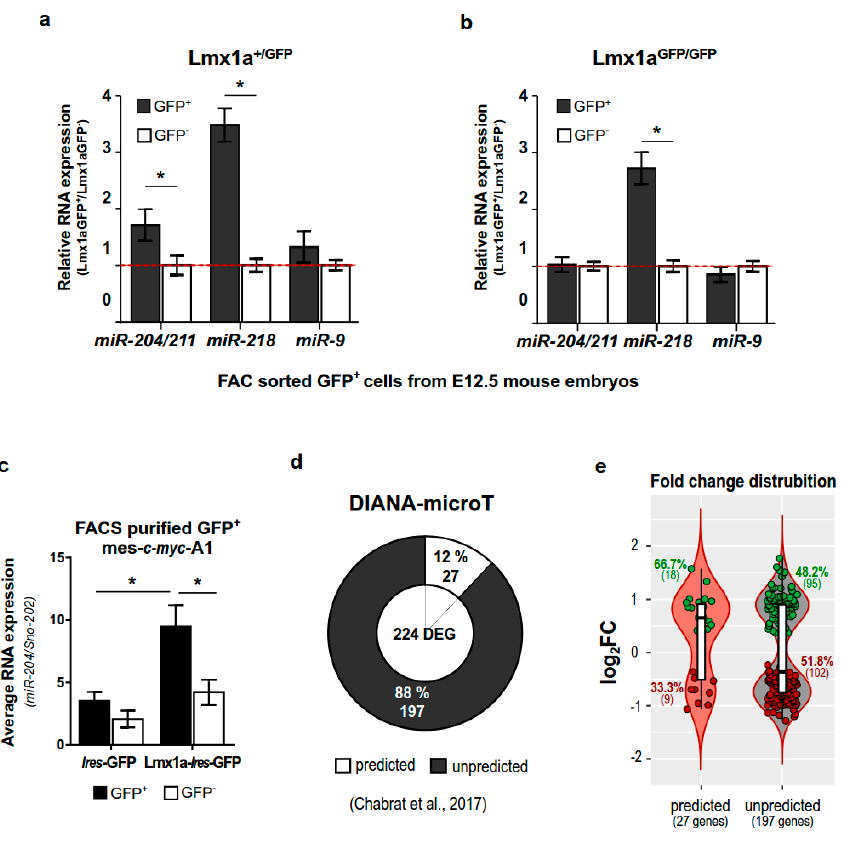
Figure 2. Lmx1a levels influence miR-204/211 expression and its repressive activity. ( a , b ) TaqMan assay for miR-204/211, miR-218, and miR-9 on FACS-purified GFP + and GFP − cells isolated from microdissected midbrains of Lmx1a +/GFP and Lmx1a GFP/GFP E12.5 embryos. miRNA values are normalized on the reference sno-202 and represent relative to control as mean ± SD of 2 −ΔΔ Ct values from three embryos. * p < 0.05 (unpaired t-test with Welch’s correction), ( c ) TaqMan assay for miR-204/211 on FACS sorted GFP + and GFP - mes-c-myc-A1 infected with LV-Lmx1a-Ires-GFP or LV-Ires-GFP. Values are normalized on the reference sno-202 and represent the mean ± SD of 2 −Δ Ct values from three independent experiments. * p < 0.05 (one-way ANOVA + Tukey post hoc test). ( d ) Representation of the frequency of miR-204/211 target genes among the 224 differentially expressed genes (DEG) in mDAn knocked out for Lmx1a/b [56]. The percentage and number of genes are reported. DIANA microT-CDS was used to identify targeted genes (miTG score > 0.5). ( e ) Fold change distribution for predicted and unpredicted target genes of the miR-204/211 among the 224 DEG derived from Chabrat’s publication [56]. The percentage and number of genes are reported. Boxes in the violin plot represent the median, the 25th to 75th percentiles, and single values of log 2 (Foldchange).